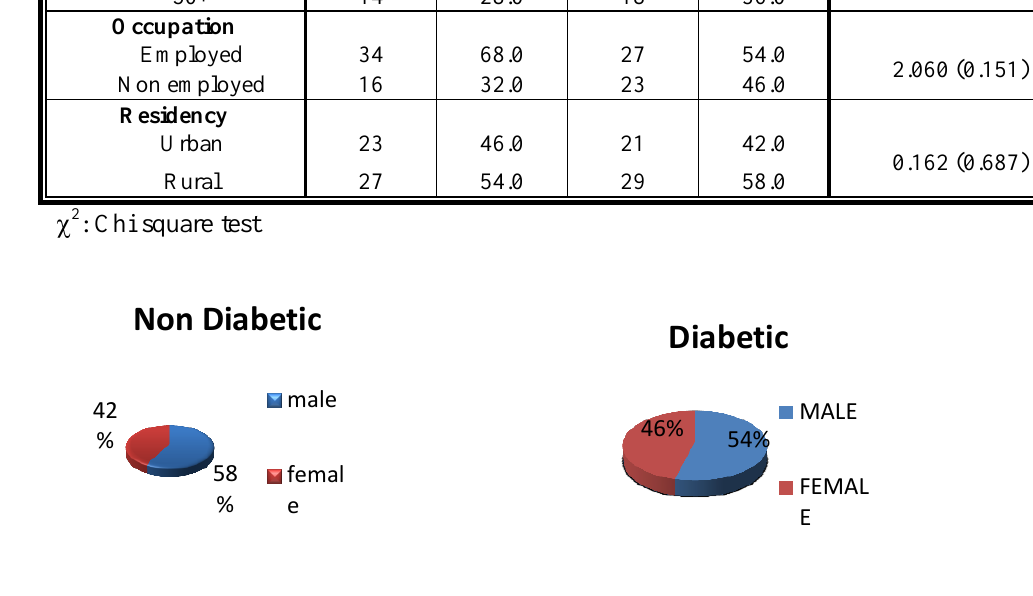
Figure 7: Demographic data of the studied patients group (sex)